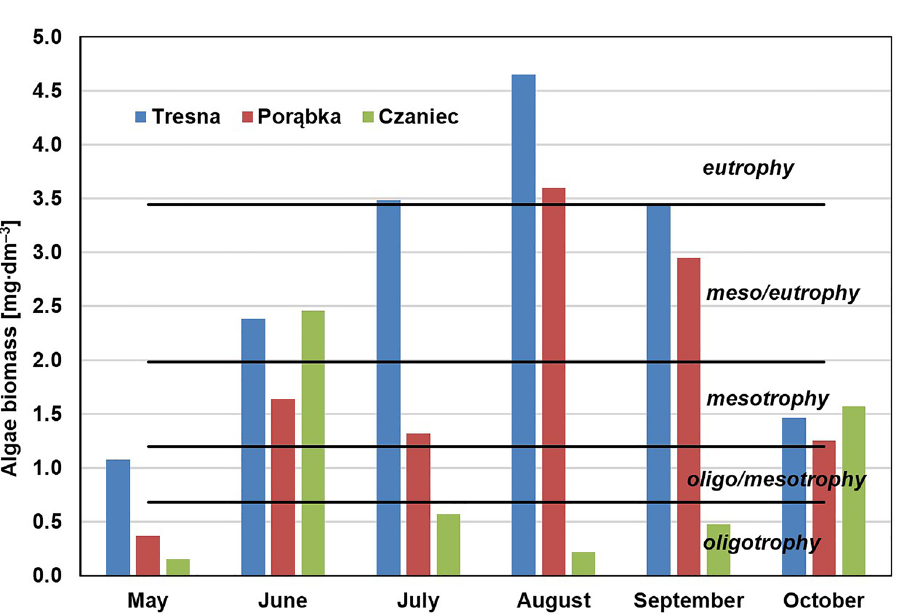
Figure 4. The planktonic algae biomass in water of the Soła cascade reservoirs in 2019 year and the trophic classification of Heinonen 41